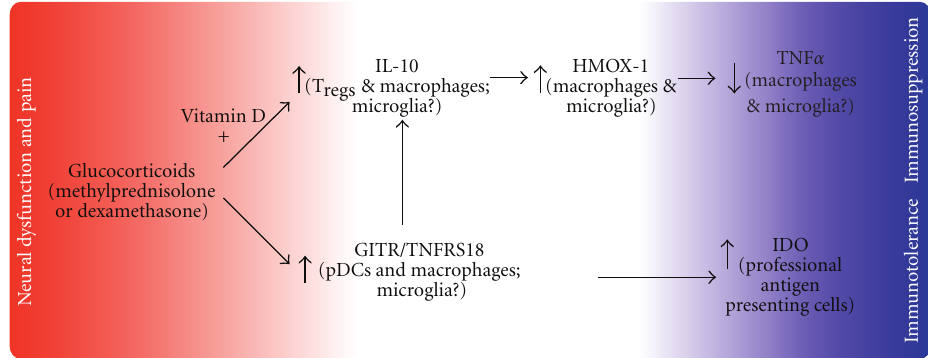
Figure 2: Glucocorticoids exert well-established relief from MS attacks, which last up to 30 days. Glucocorticoids exert immunoregulatory e ff ects via transcriptional regulatory signaling in large part through GITR to IDO ([4, 5]) and IL-10 to HMOX-1 [8, 70, 71]). GITR activation is also known to lead to increased IL-10 production [72]. The representative glucocorticoid target genes of interest examined in this study with desirable e ff ect are shown in bold. Multiple sclerosis patients are specifically lacking in CD46-stimulated IL-10 secretion and su ff er from an over-proliferation of myelin autoreactive T